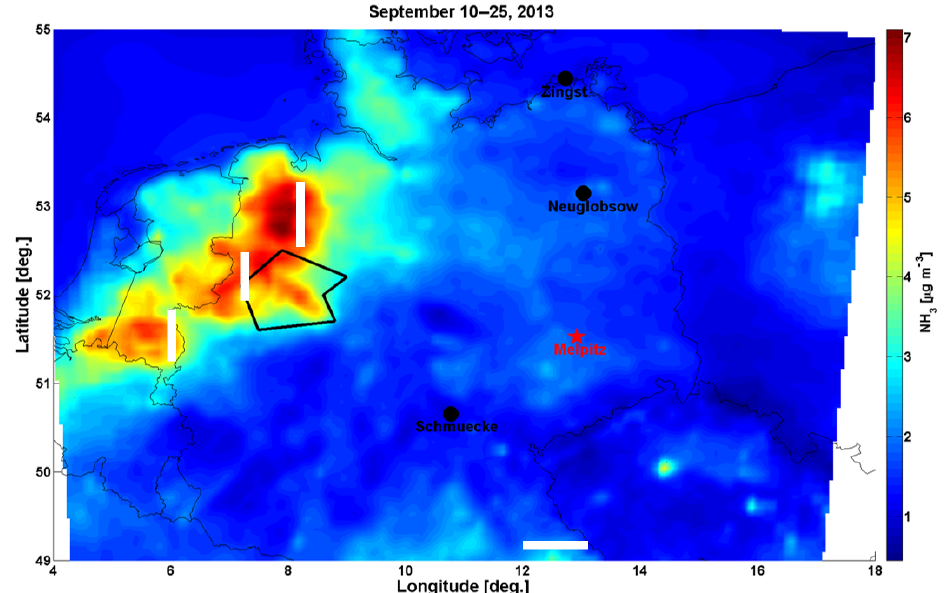
Figure 1. Results (domain N2) of the NewN2O5 case of averaged NH 3 mass concentration during 10–25 September 2013. The added emissions of marker tracer (T-NH3) from NH 3 source regions (the Netherlands and southern Germany) are marked by the white bars. The locations of the considered measurement stations are also marked: Neuglobsow, Schmücke, and Zingst are marked by black dots; Melpitz is marked with a red star and its results are discussed in Figs. 2 and 3. The region with the most significant organic coating effect is highlighted by the black polygon and will be analysed together with Fig.